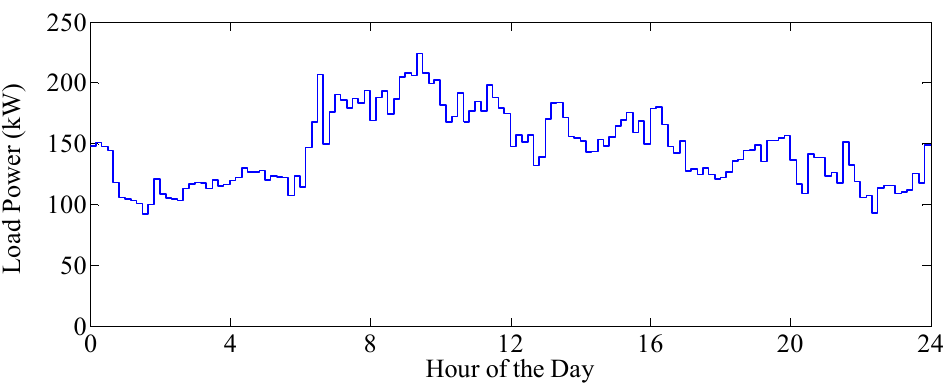
Figure 4. Load demand daily profile.